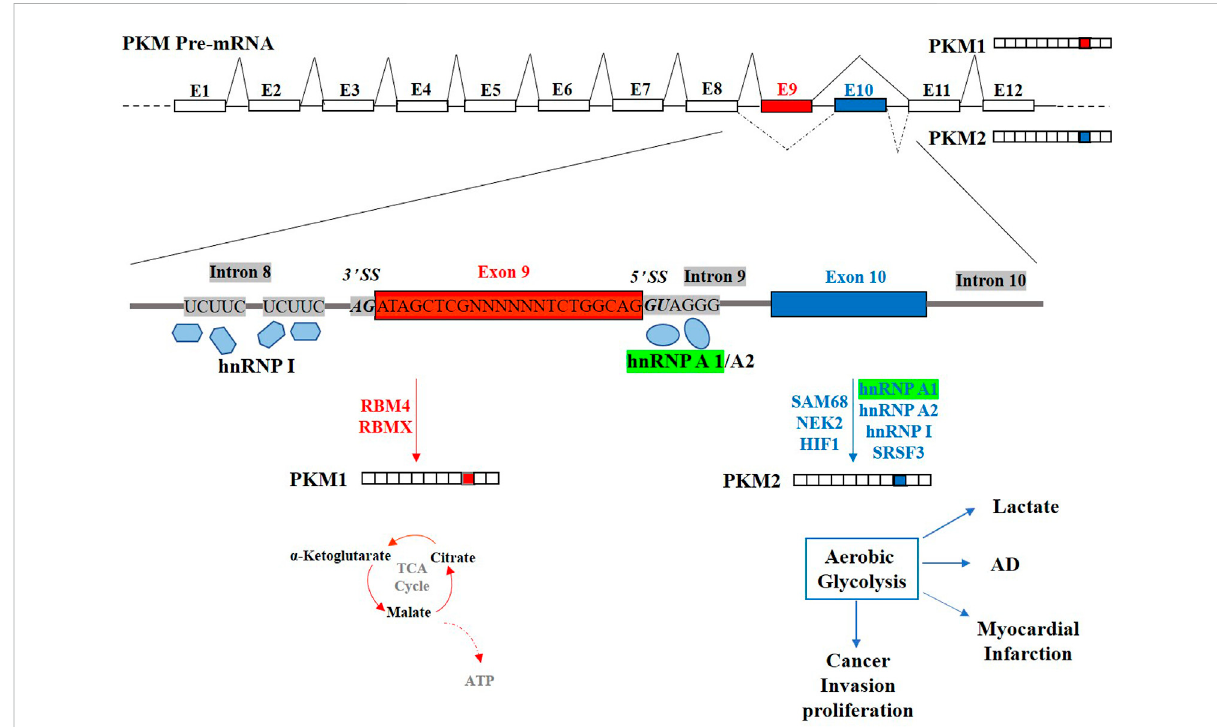
FIGURE 2 Schematic representation of the human pre-PKM gene and the regulation of its mutually exclusive alternative splicing. Exon9 (E9) and Exon10 (E10) of PKM gene are two mutually exclusive exons. Generation of the PKM1 isoform using E9 is crucial for tricarboxylic acid cycle (TCA cycle) and oxidative phosphorylation producing maximum ATP. PKM2, including E10 but not E9, results in aerobic glycolysis (the Warburg effect) with high lactate production, contributing to AD, myocardial infarction and cancer progression. hnRNP A1 (Highlighted in Green) suppresses the E9 inclusion bybinding to 5 ′ SSdownstream E9 and co-regulation with cooperativefactors (hnRNP A2, hnRNP I, SRSF3, SAM68, NEK2 and HIF1) and antagonistic factor (RBMX and